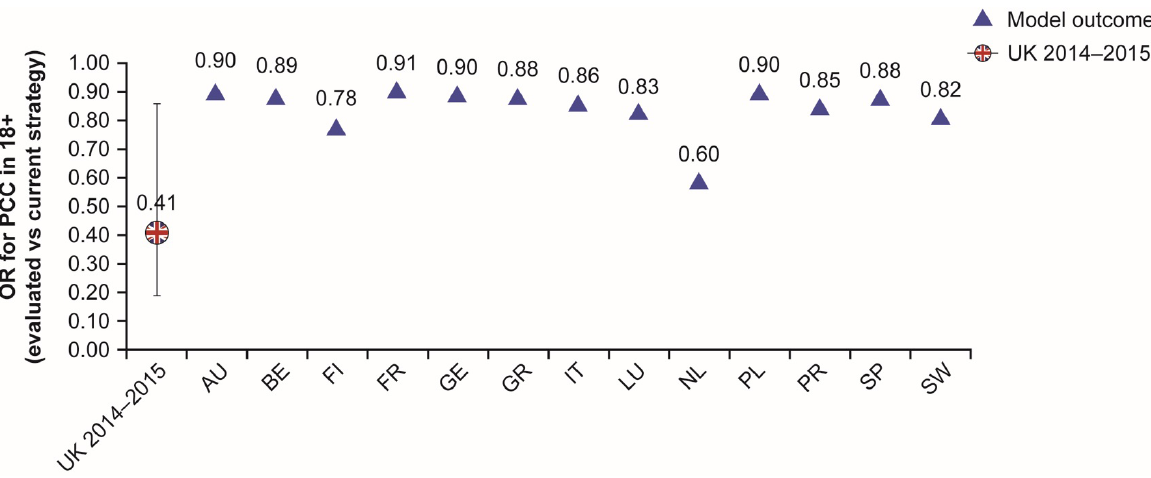
Figure 2. OR for PCC in Non-target Population (≥18 year-old), Model versus UK 2014–2015